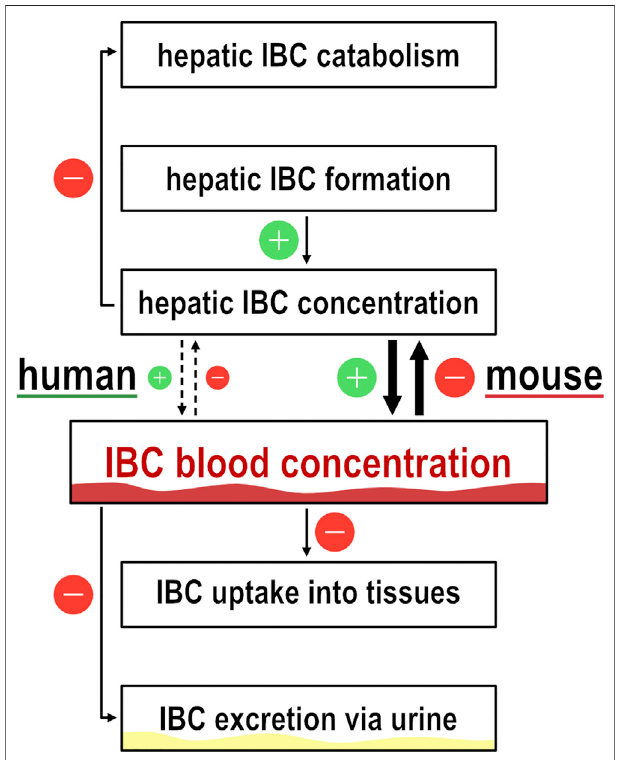
FIGURE 8 | Illustration of isobutyrylcarnitine dynamics. Flow chart to illustrate the dynamics of isobutyrylcarnitine blood concentrations. Icons with ‘ + ’ and ‘ − ’ illustrate the effect on IBC blood concentration by the respective